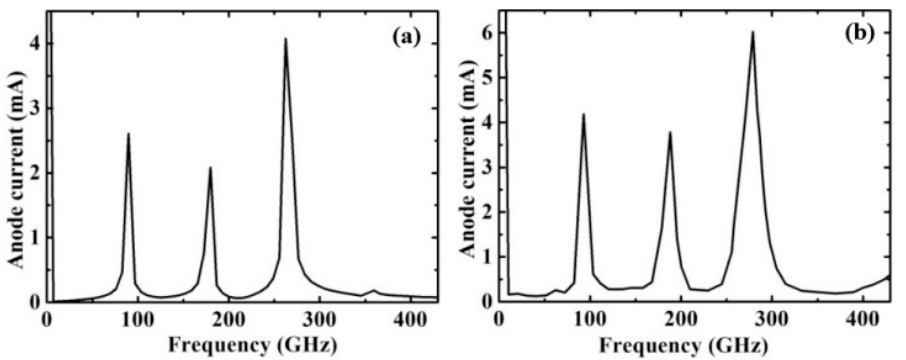
Figure 7. The frequency spectrums for the single-2DEG-channel SPD (a) and triple-2DEG-channel SPD (b) respectively.